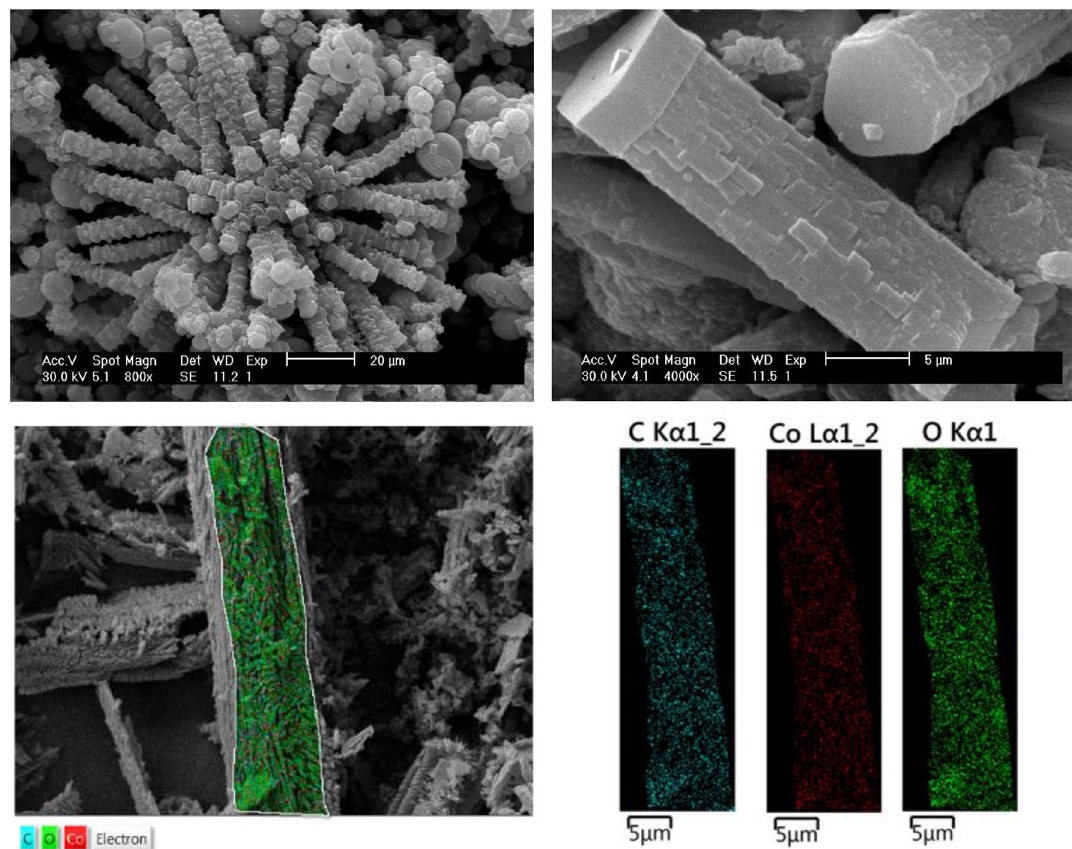
Figure 7. FESEM images and EDX mapping analyses of